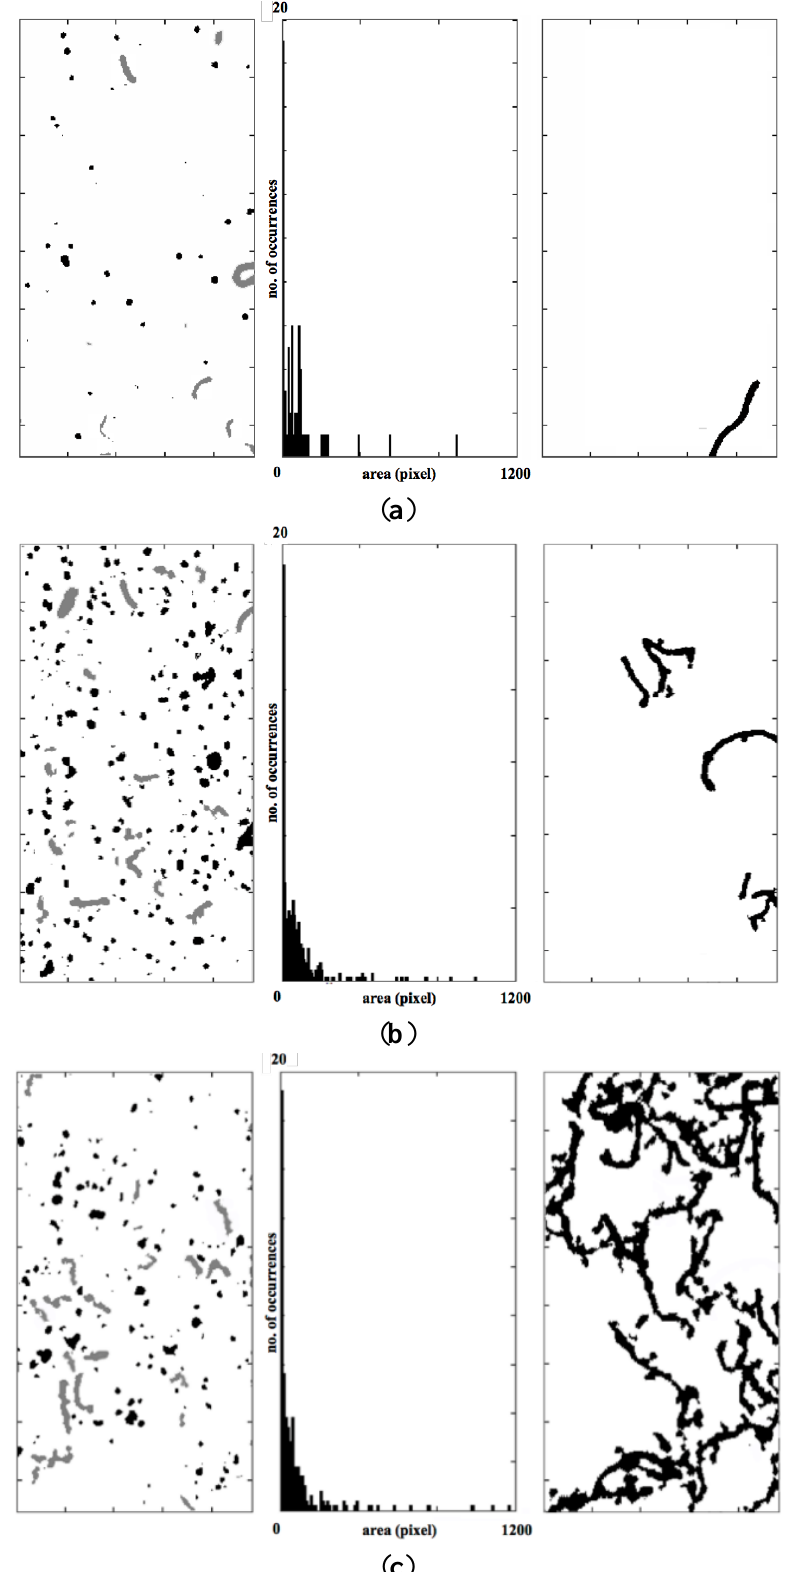
Figure 10. Output results for the three samples image: the dusts classification (black for the circular type and grey for the filiform type), the dusts amplitude spectrum and the discarded elements due to the scanning windows